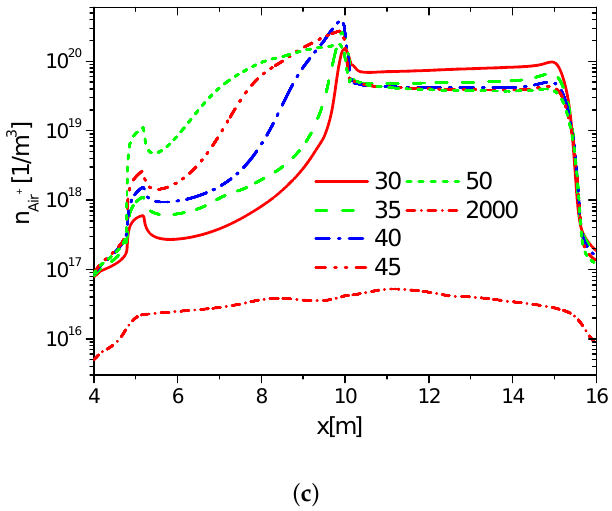
Figure 6. The distributions of n e , n Air − and n Air + on the wall surface at time 30 ns, 35 ns, 40 ns, 45 ns, 50 ns, and 2000 ns in the fall phase in Case 1.